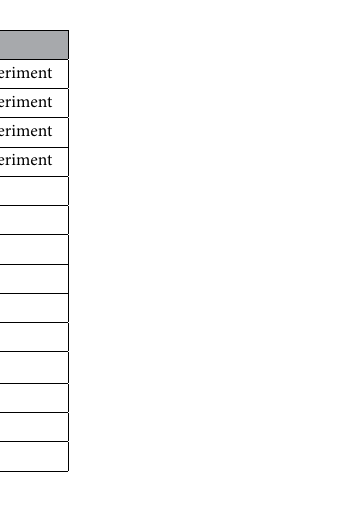
Table 3. Mechanical parameters of water rush